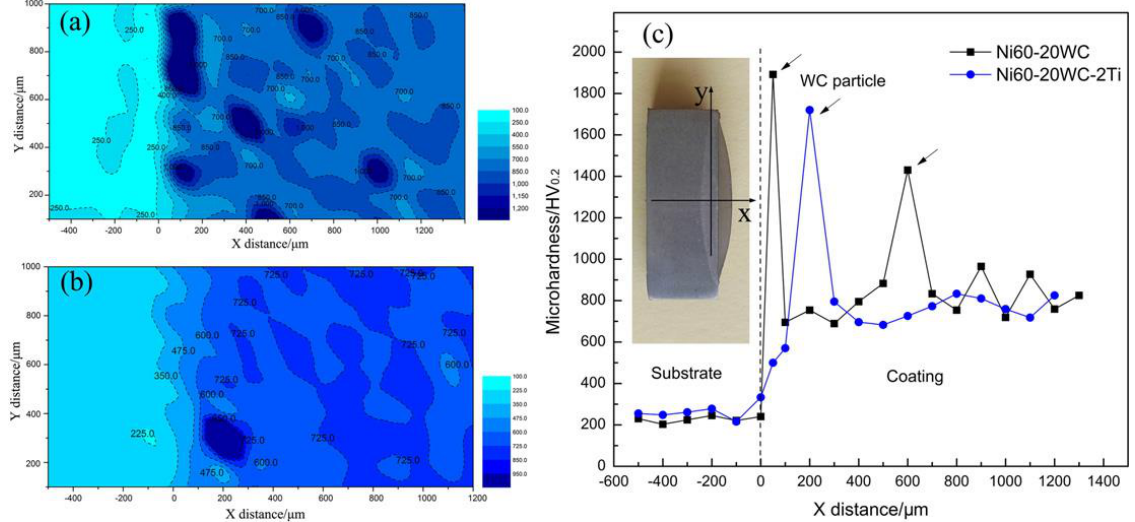
Figure 9: Microhardness test results (a): map distribution in Ni60-20WC coating; (b): map distribution in Ni60-20WC-Ti coating; (c): line profiles of two coatings